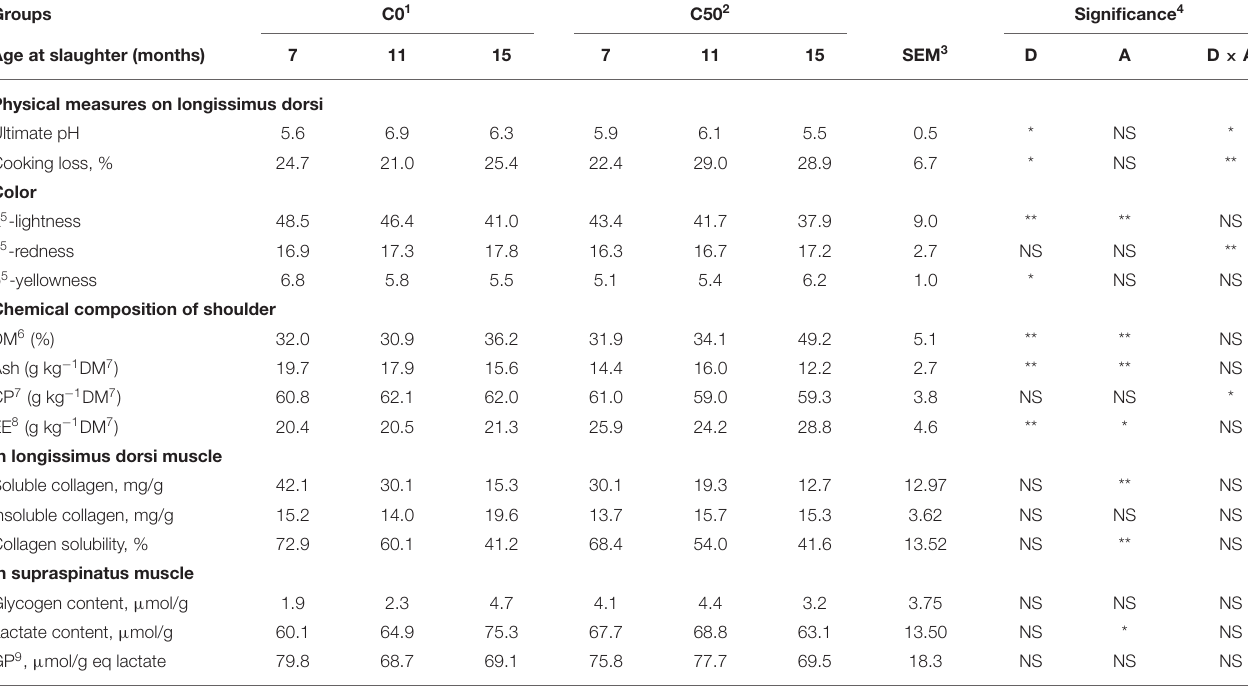
TABLE 3 | Physical measurements on muscle and chemical analyses on shoulder and muscles of Creole goats according to diet and age at slaughter. Groups C0 1 C50